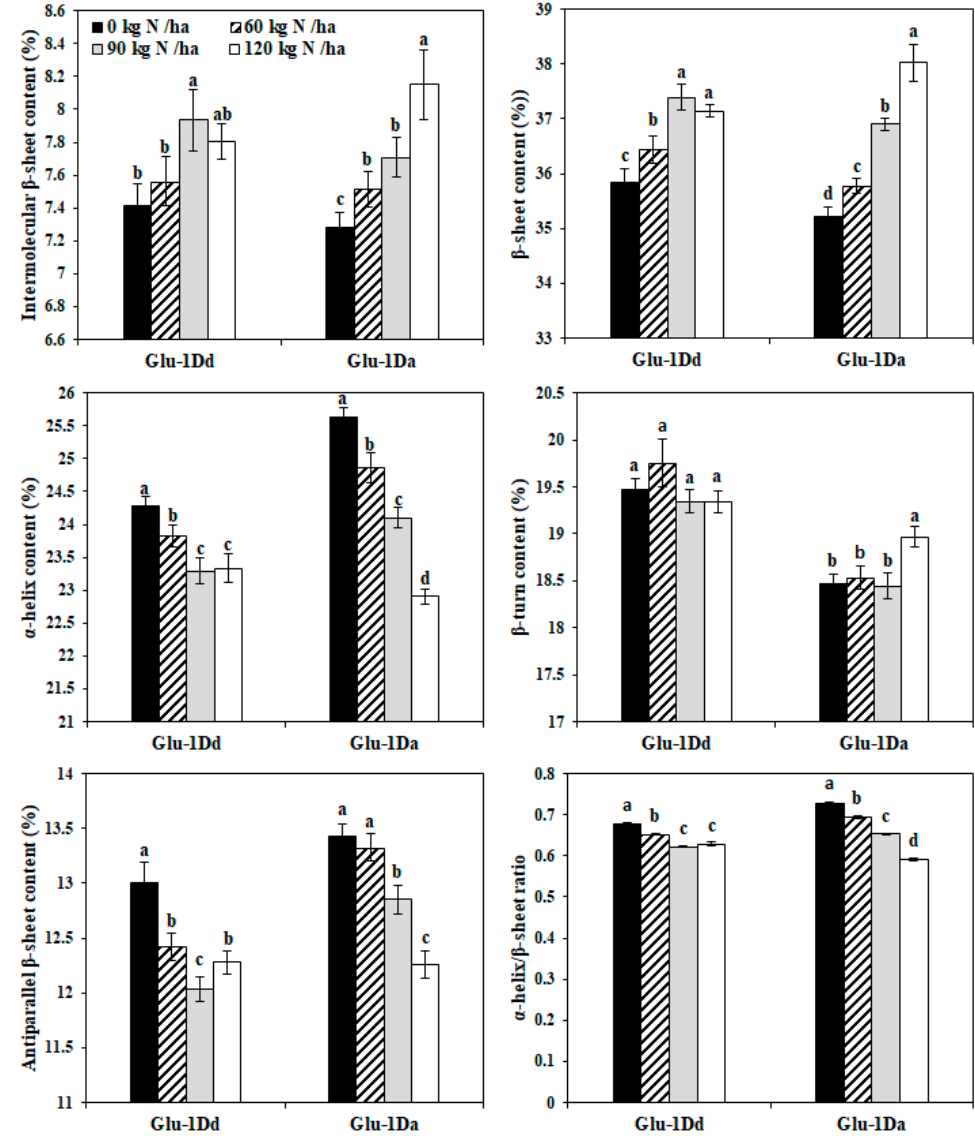
Figure 4. Percentages of secondary structure of gluten containing Glu-1Dd and Glu-1Da under N treatment. Same letter in the different columns for each material indicate no significant difference ( p > 0.05). Data are presented as the mean of two years.